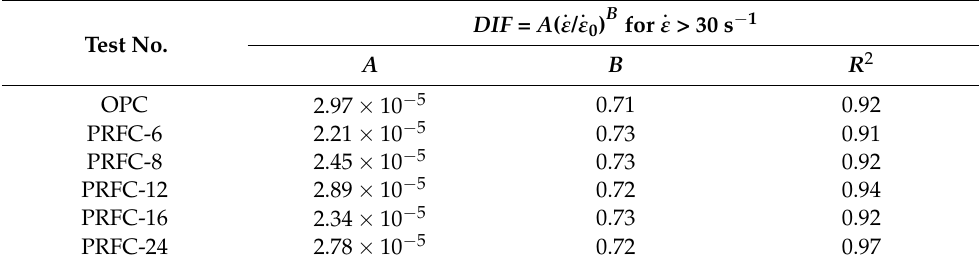
Table 8. Coefficients in the proposed DIF empirical formula for PFRC.